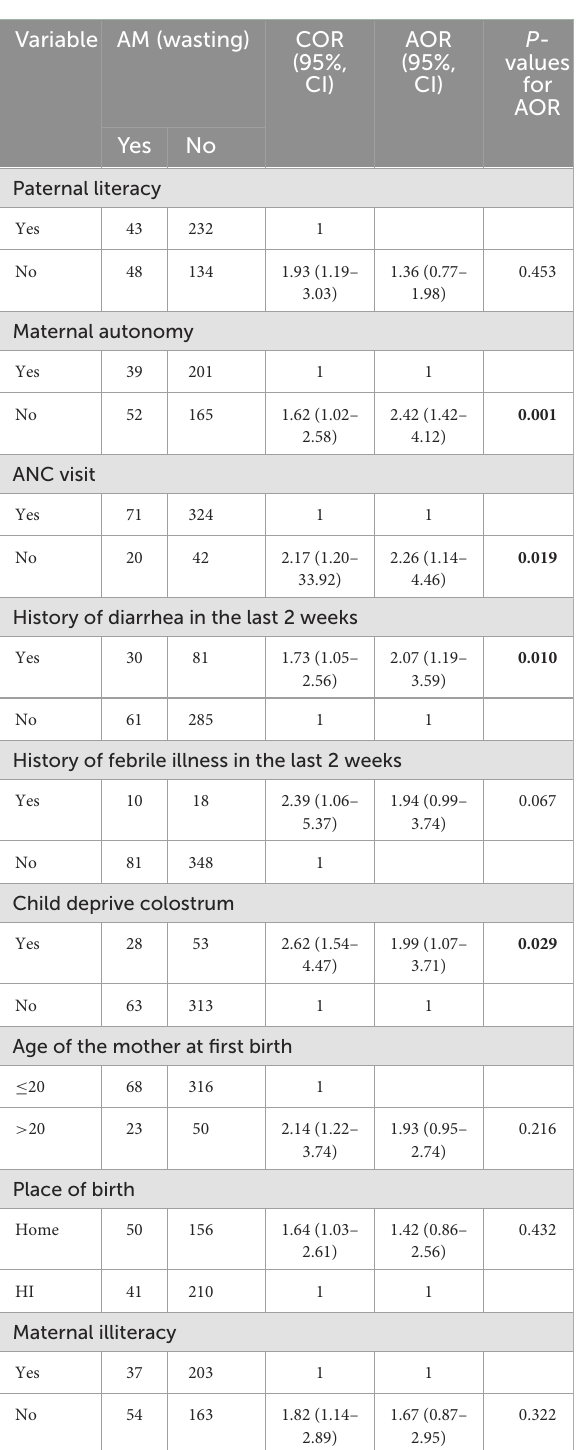
TABLE 5 Factors associated with acute malnutrition (wasting) among children under-five years, of Shashemene district, Oromia region, Ethiopia, and July 2018